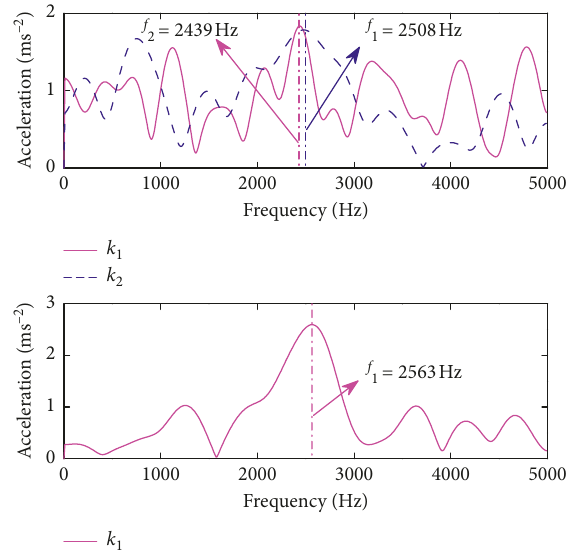
Figure 4: Amplitude-frequency spectra for estimating the types of impulse responses in Case